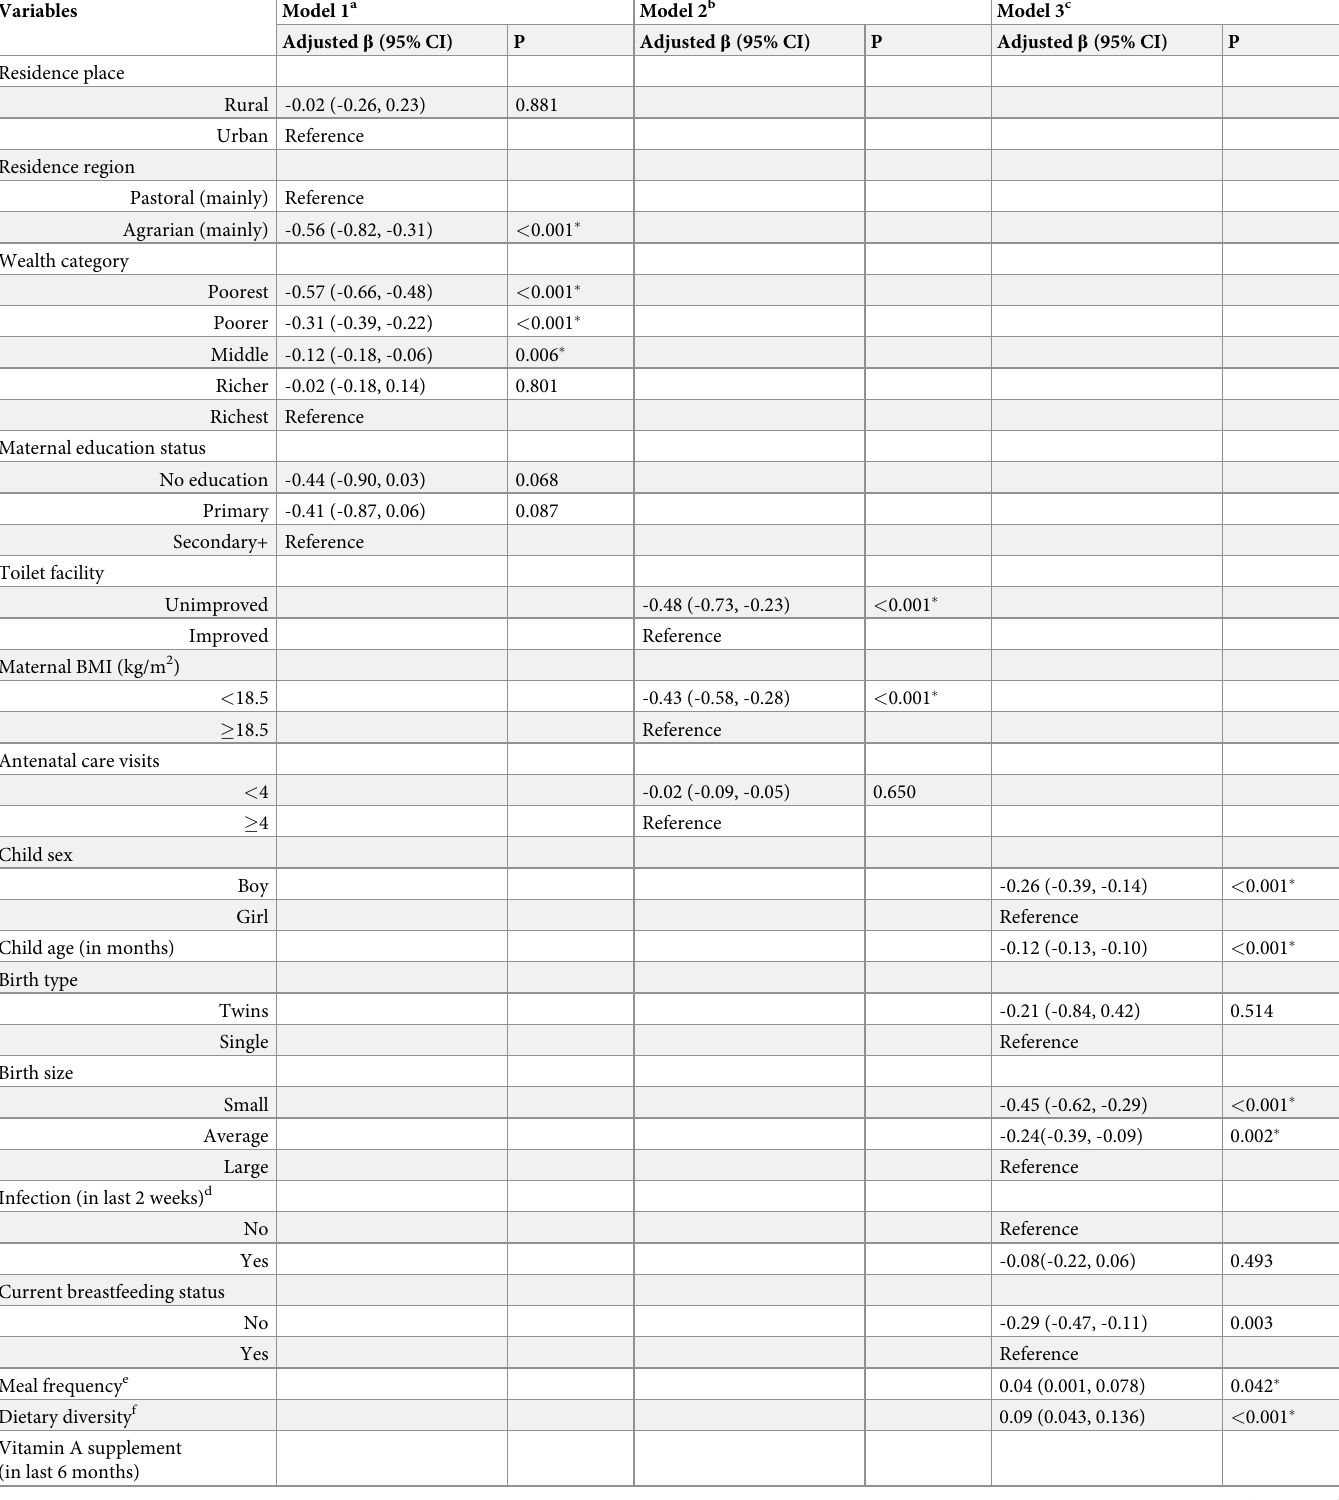
Table 3. Hierarchical regression analysis of the relation of basic, underlying, and proximal factors with